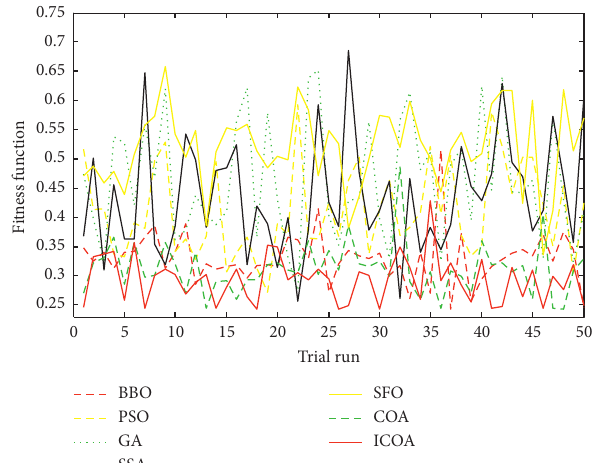
Figure 11: The fitness values of seven methods in 50 trial times for the second case.